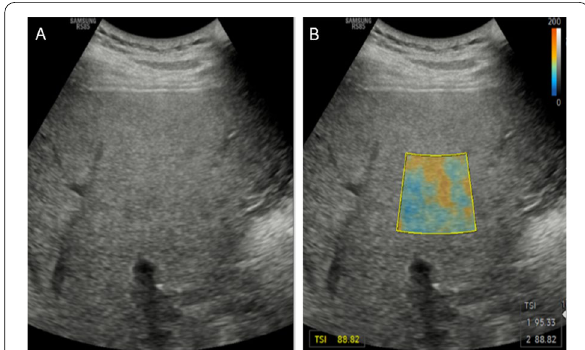
Fig. 17 a B-mode image of an unidentified patient with suspected liver steatosis. b Tissue scattering imaging (TSI) based on Nakagami histogram modeling and post-processing. Reproduced with permission from